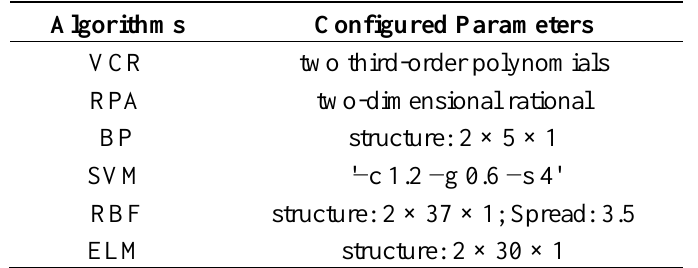
Table 7. Configured parameters of algorithms using 5 × 11 calibration.